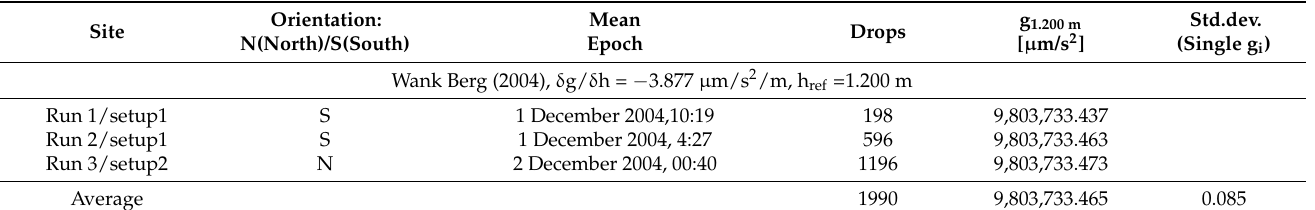
Table 2. Absolute gravity values of the FG5-220 measurements at the bottom and top of Mt. Wank (facilities of Bayerische Zugspitzbahn Bergbahn AG). The gradient insensitive sensor height depends on the gravimeter setup and is about 1.25 m above floor level for the 2019 setups (FG5-220, X-version) and 1.20 m for the 2004 setups with the original gravimeter version of FG5-220. For the Wank stations, the reference height h = 1.200 m (above floor point) has been chosen for comparison reasons. The average of a station determination has been calculated as the arithmetic mean of the different setups. Before, a setup mean was calculated as a weighted mean of the runs (no. of drops is the weight of a run). Std.dev. is the standard deviation calculated from the drop